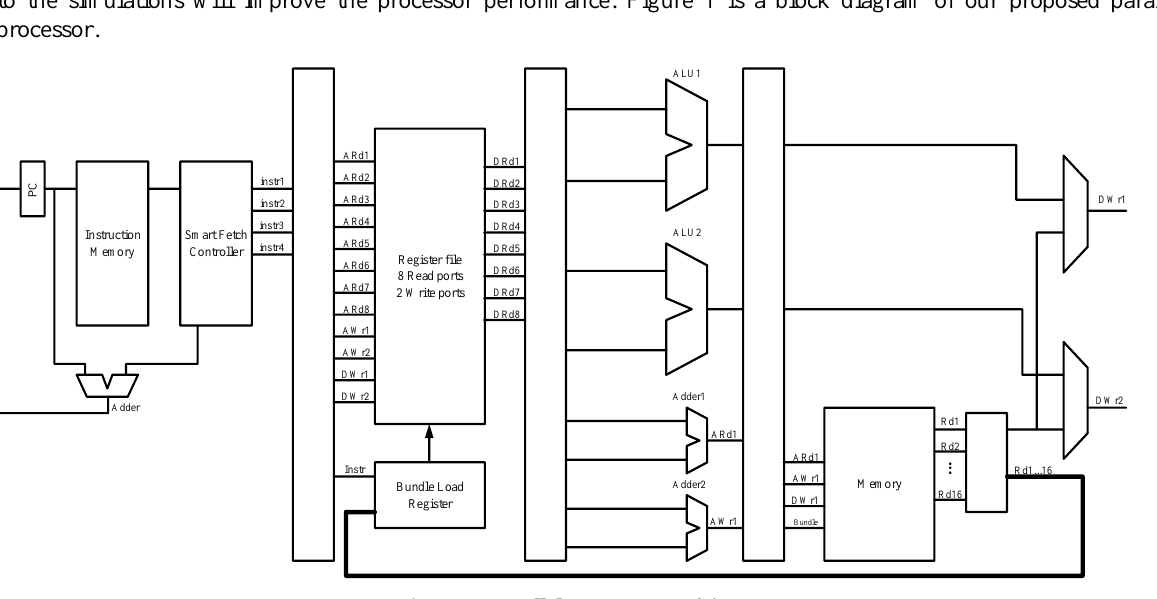
Figure 1. Parallel processor architecture.